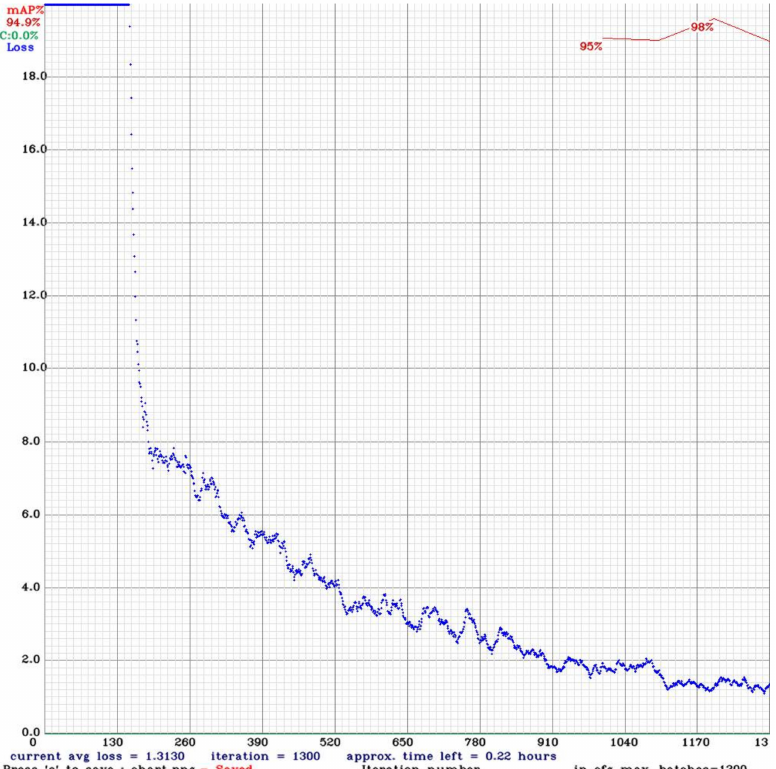
Figure 8. Loss function after training the YOLO